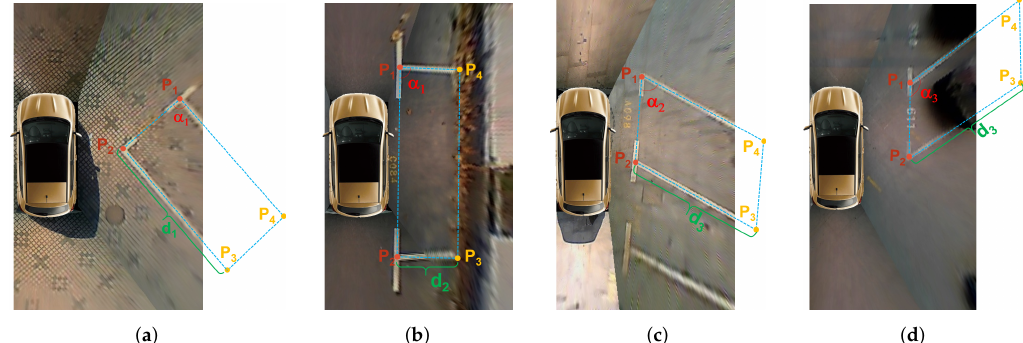
Figure 6. Complete parking slot inference. ( a – d ) are the perpendicular parking slot, the parallel parking slot, the slanted parking with an acute angle, and the slanted parking with an obtuse angle respectively. Their depth is d 1 , d 2 and d 3 respectively, and their parking angle is α 1 , α 2 and α 3 respectively. p 1 , p 2 are two visible paired marking points, and p 3 , p 4 are two invisible